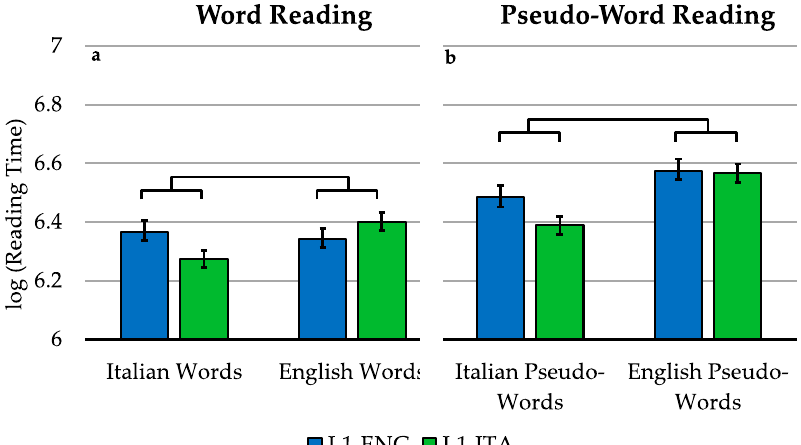
Figure 2. Word reading and pseudo-word reading. Mean log-transformed voice onset times for the reading task in the two languages for L1-Italian and L1-English bilinguals. Panel ( a ) refers to word reading. Panel ( b ) refers to pseudo-word reading. Error bars indicate the standard error of the mean. The reading times refer to accurate trials.